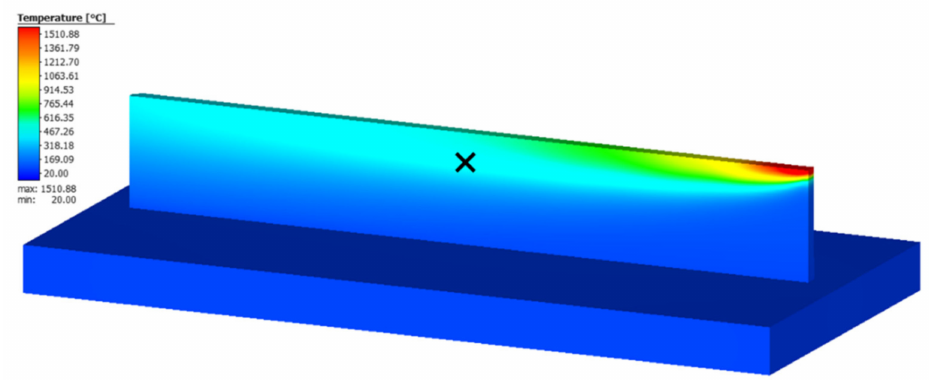
Figure 12. Temperature field in the welding simulation for wall structure (length 300 mm) and energy input per unit length 4 kJ/cm with layer 25.